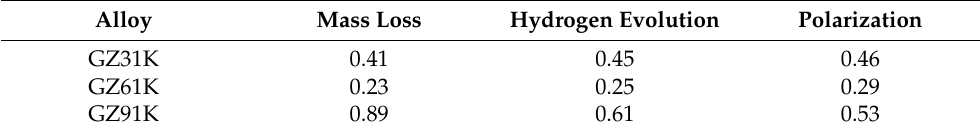
Table 5. Corrosion rates (mm/year) of the T6-treated alloys calculated by different methods. Alloy